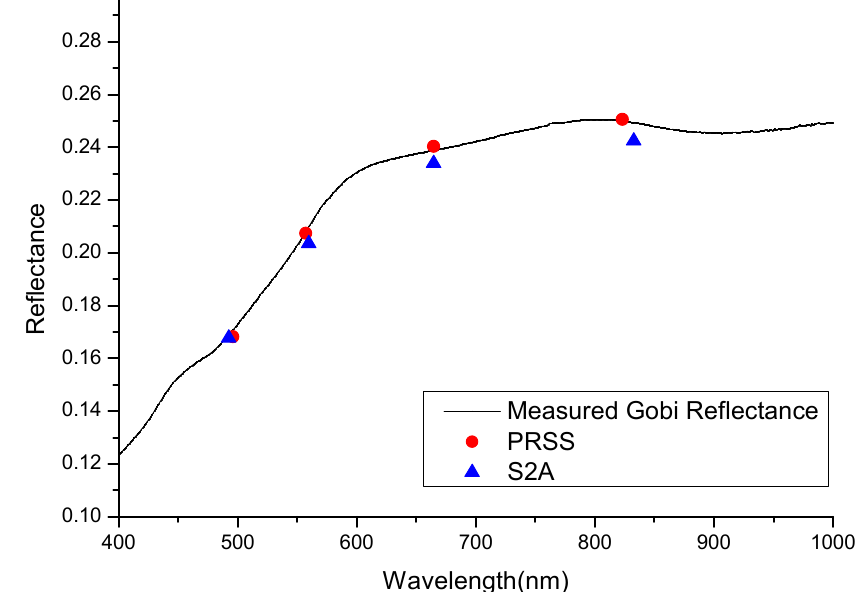
Figure 16. Comparison between the Gobi ground reflectance obtained by PRSS-1 using RCRII model and Sentinel-2 using the reflectance inversion model and measured Gobi reflectance by ASD.